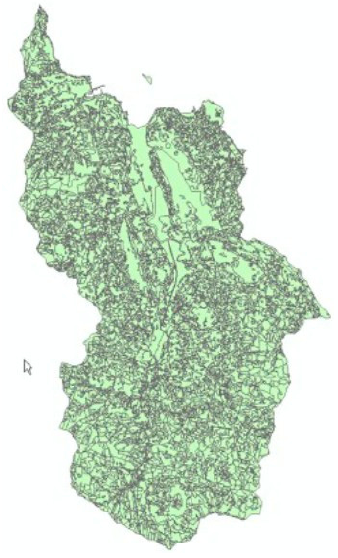
Figure 3. Urdaibai forestry map [16].